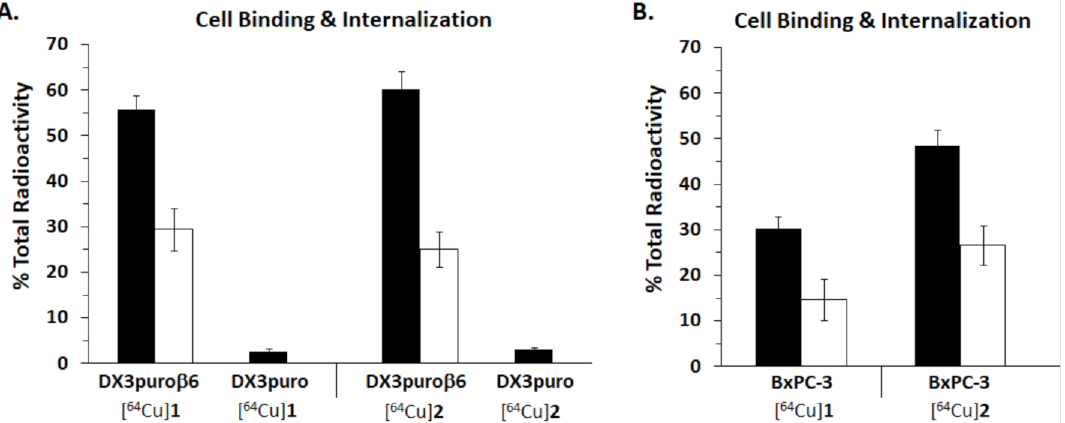
Figure 2. Cell binding ( (cid:4) ) and internalization ( (cid:3) ) for [ 64 Cu]Cu DOTA-EB- α v β 6 -BP ([ 64 Cu] 1 ) and [ 64 Cu]Cu DOTA-IP- α v β 6 -BP ([ 64 Cu] 2 ) for ( A ) DX3puro β 6 ( α v β 6 +) and DX3puro( α v β 6 − ) cells and ( B ) BxPC-3 ( α v β 6 +)